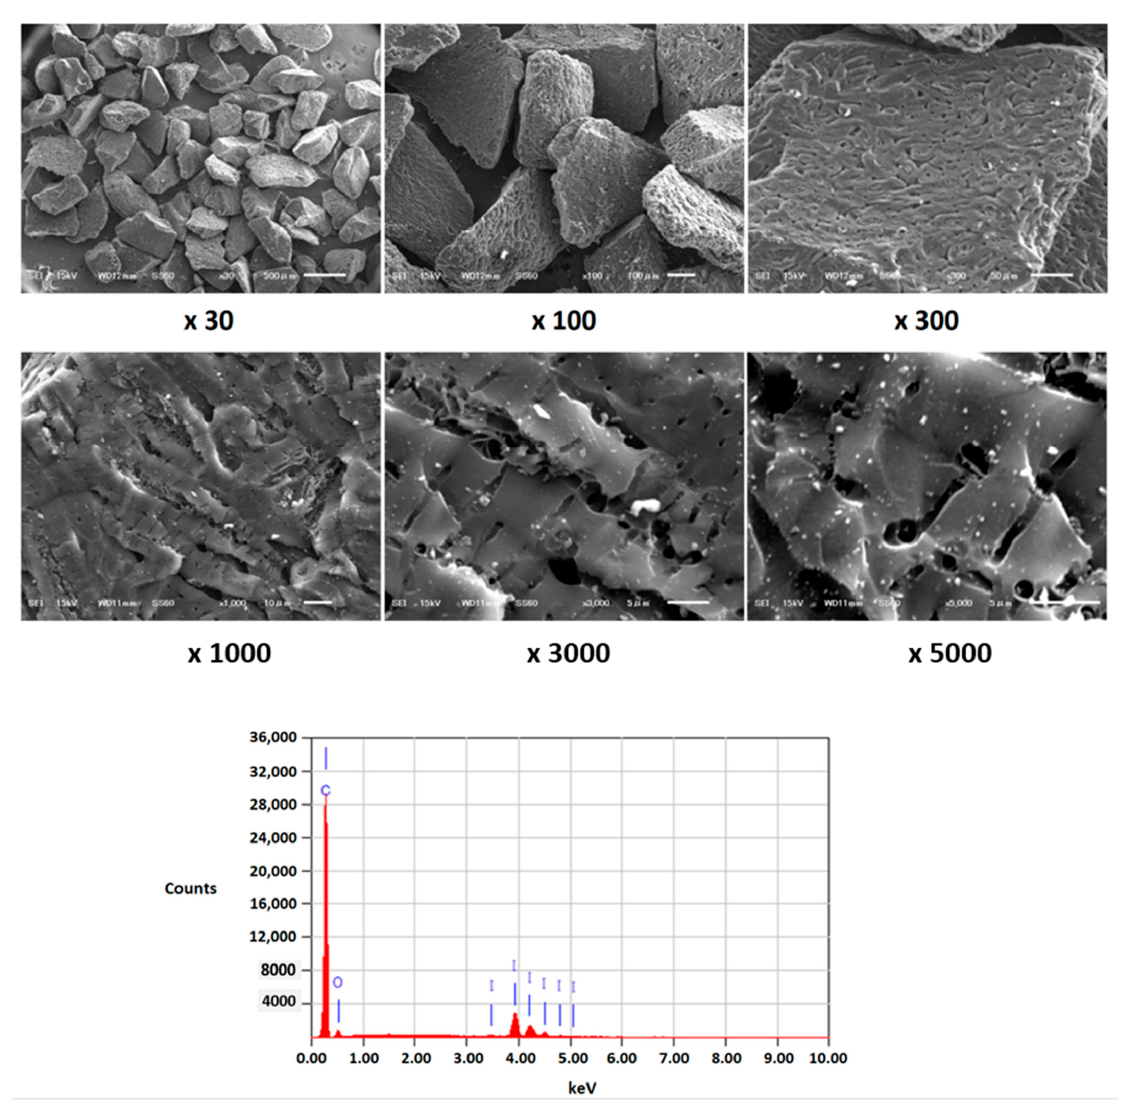
Figure 1. SEM images (various magnifications) and EDS elemental analysis of IodAC (from our paper published in MDPI’s Water [28]).